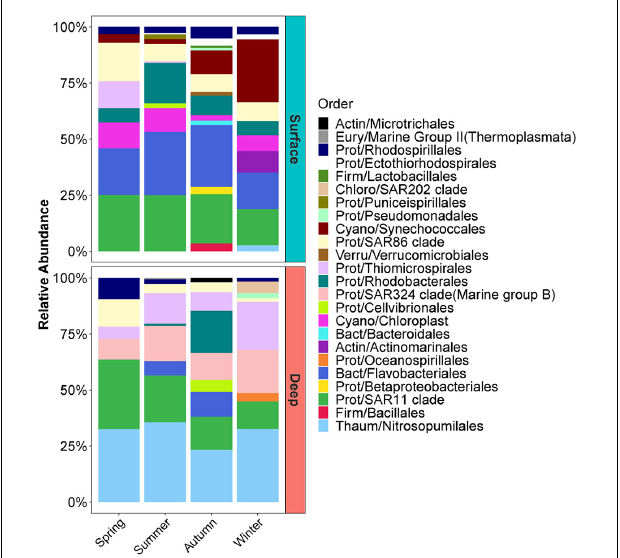
FIGURE 3 | Seasonal changes in subantarctic surface and deep (500 m) water prokaryotic community composition of taxa with > 5% relative abundance grouped at order level. Corresponding Phylum groups are indicated as follows: Actin, Actinobacteria; Bact, Bacteroidetes; Chloro, Chloroflexi; Cyano, Cyanobacteria; Eury, Euryarchaeota; Firm, Firmicutes; Prot, Proteobacteria; Thaum, Thaumarchaeota; Verru, Verrucomicrobia. Samples were collected over 3 years from the Munida Microbial Observatory Time-Series (MOTS) and grouped into meteorological